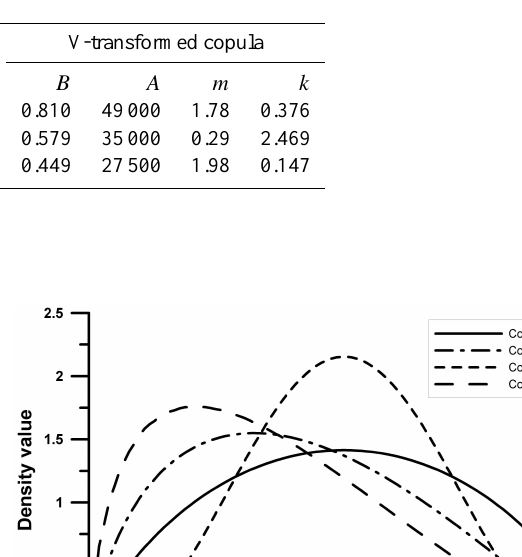
Table 2. Parameters of the fitted copulas.